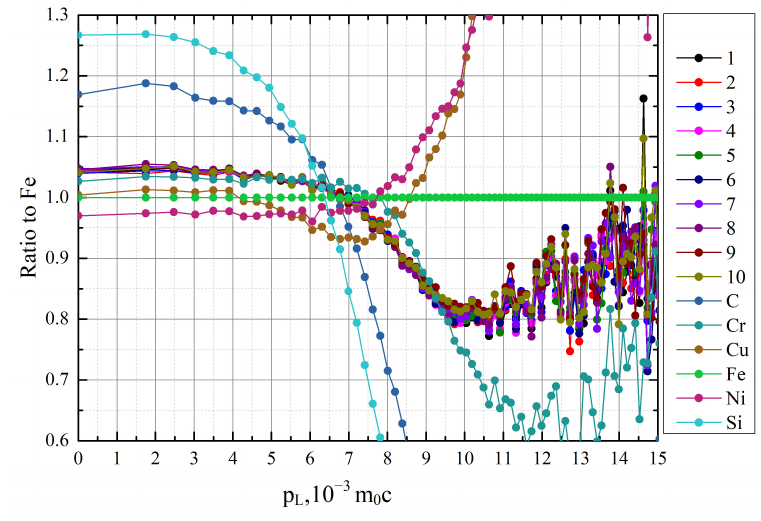
Figure 3. Ratio curves to Fe for GCr15 samples with different cutting parameters and steel components. Description of samples is given in Table 1.